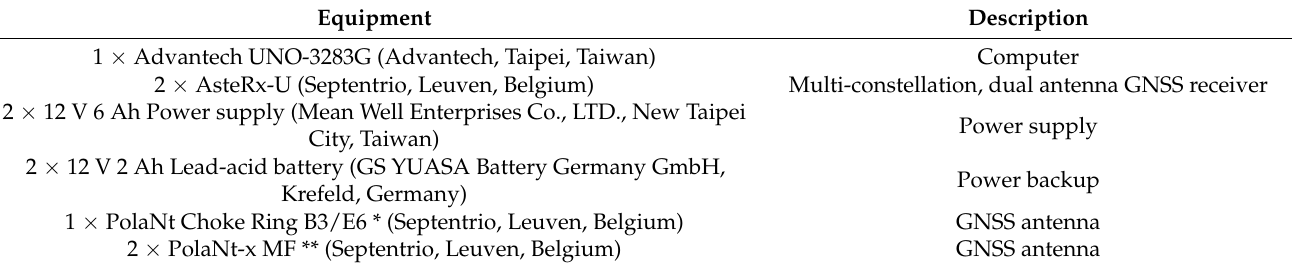
Figure 7. Experimental setup for the maritime data-collection campaign. ( a ) the GNSS antennas installed on the bow lighting mast of the Catuneanu vessel; ( b ) the special rack containing the GNSS receivers and the external power supply. Table 7 contains the list of equipment used for the maritime data-collection campaigns. Table 7. Equipment used in the maritime data-collection